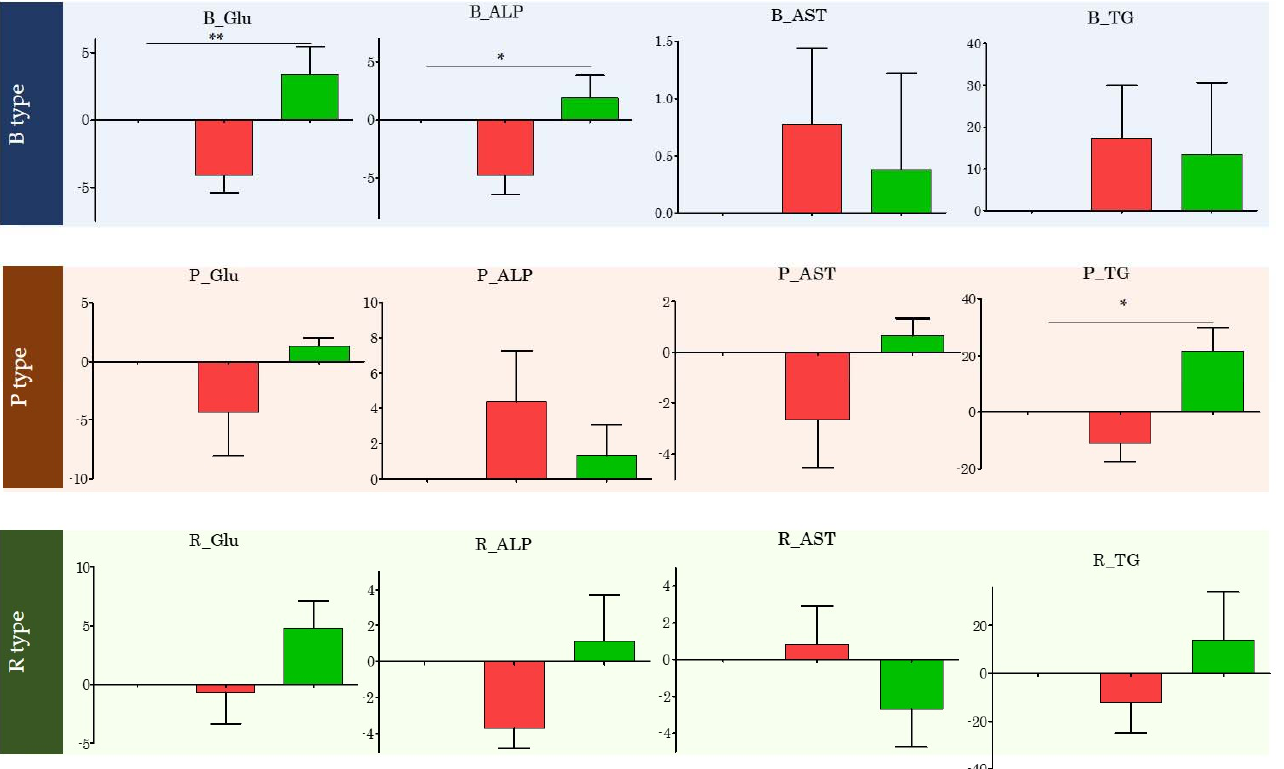
Figure 5. Changes in specific blood index values by Enterotype of all subjects. This picture was created to observe the change effectively. The red bar shows the change in after by setting the baseline value to 0 (reference point). The green bar shows the change in Washout by setting the value of after to 0 (reference point). One-way-ANOVA analysis was performed. * p < 0.05, ** p < 0.01.